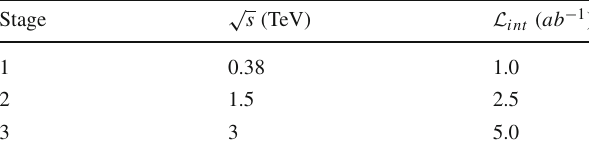
Fig. 1 Lowest order contributions to the e − e + → H + H − process Table 1 Baseline CLIC energy stages and integrated luminosities for each stage